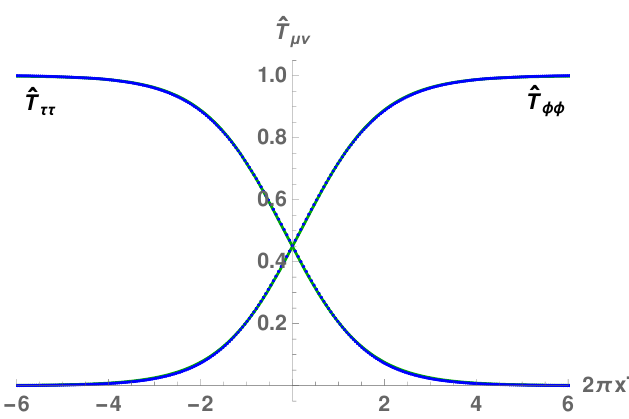
Figure 5 . Phenomenological fitting of the (normalized) components of the energy-momentum tensor ˆ T and ˆ T . Blue dots show the energy-momentum tensor extracted from the numerically ττ φφ constructed geometry of [20], and the green curves are given by the fit in equation